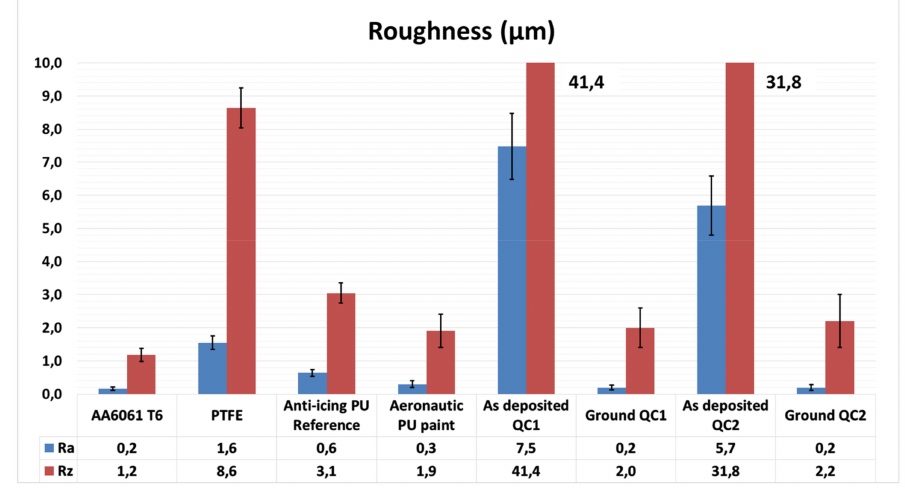
Figure 9. R a and R z